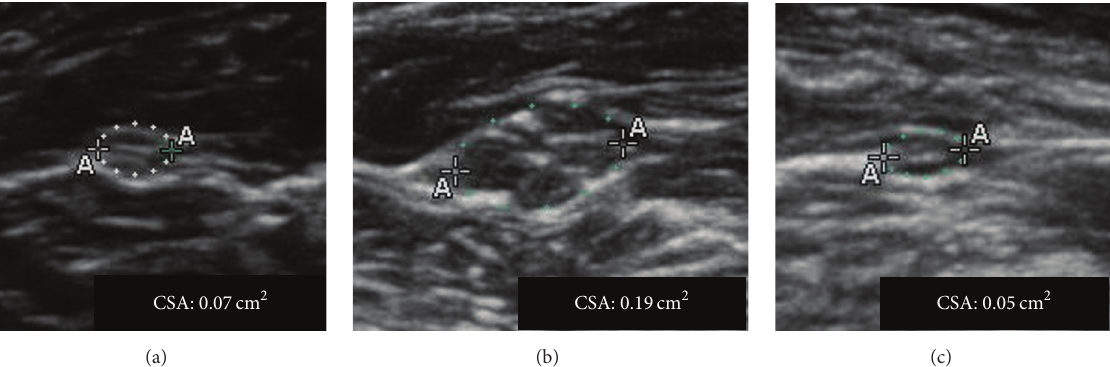
Figure 2: Median nerve axial ultrasound scan in CIDP patients at different disability state. (a) Male, 60 years old; disease duration 64 months; INCAT upper limbs score: 1. (b) Male, 63 years old; disease duration 72 months; INCAT upper limbs score: 2. (c) Male, 62 years old; disease duration 79 months; INCAT upper limbs score: